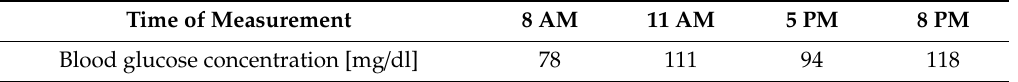
Table 2. Patient’s blood glucose level before treatment in 2005.